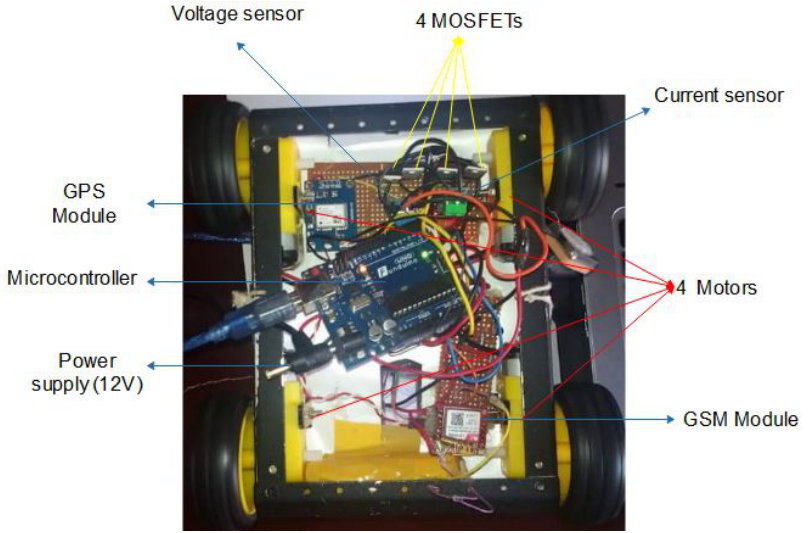
Figure 5. The embedded speed control device. Color information has been used for the detection of traffic signs [42]. Road